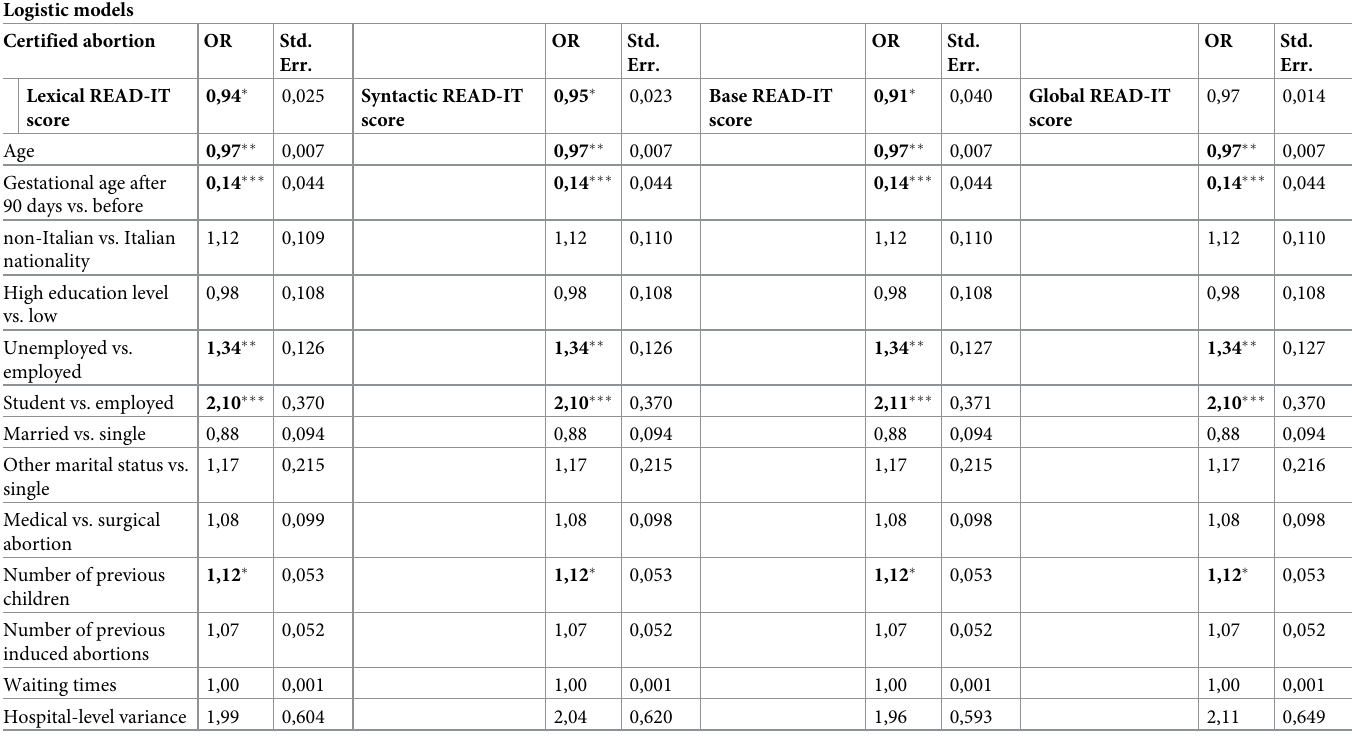
Table 3. Multilevel logistic regression